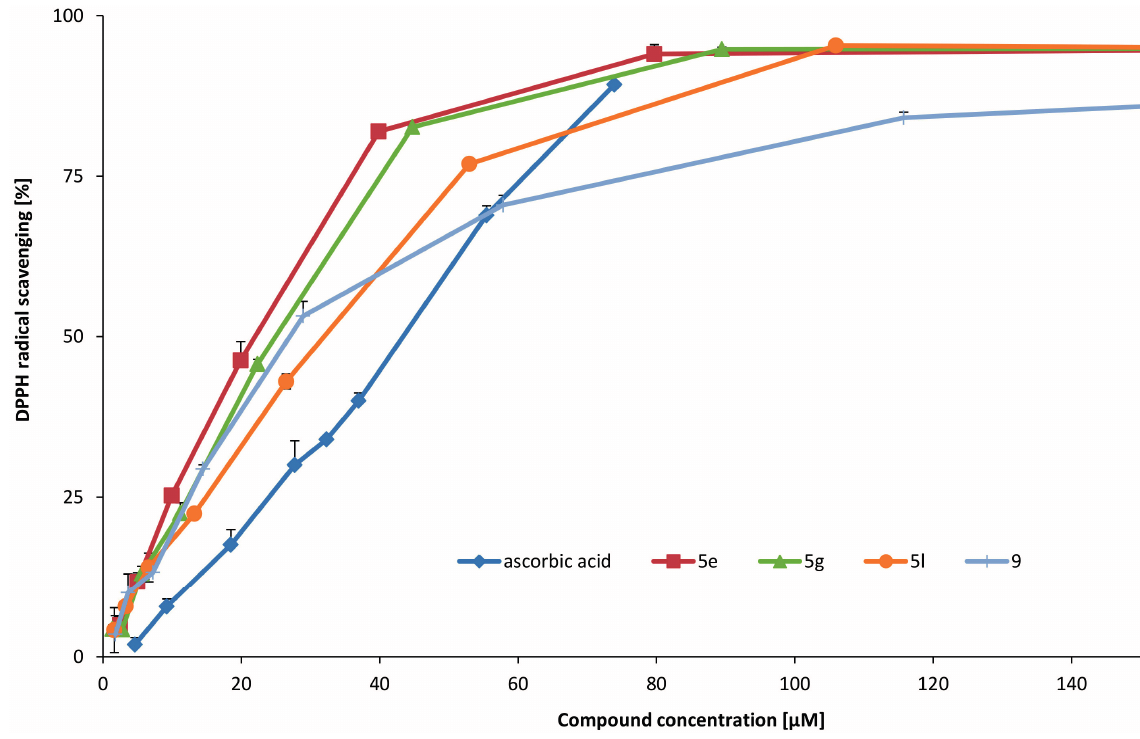
Figure 1. DPPH · scavenging of the most active compounds.